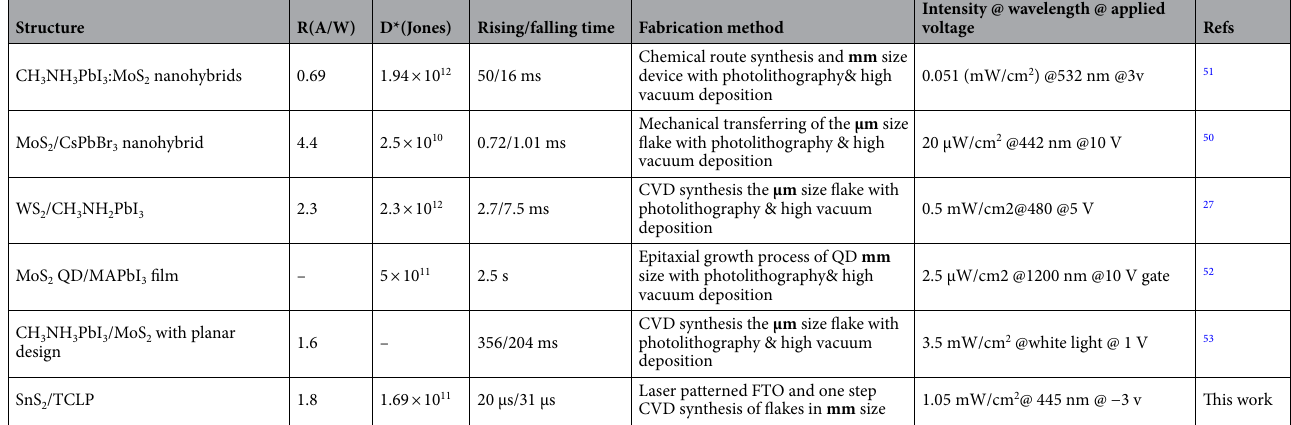
Table 1. A summary review on some published reported parameters of TMDs/perovskite-based